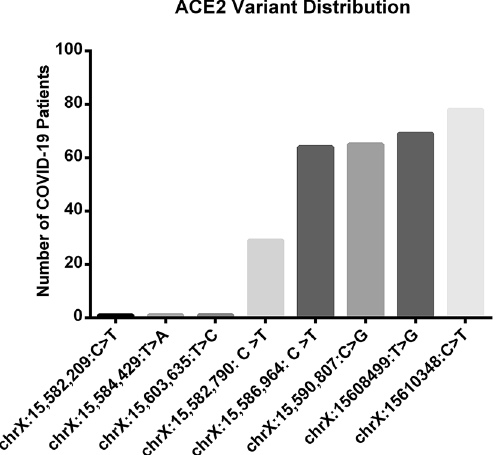
Figure 1. Distribution of ACE2 variants among the COVID-19 lean and obese patients. rs2285666 (chrX:15,610,348, C > T) has the highest distribution among the studied cohort; present in 79 patients;